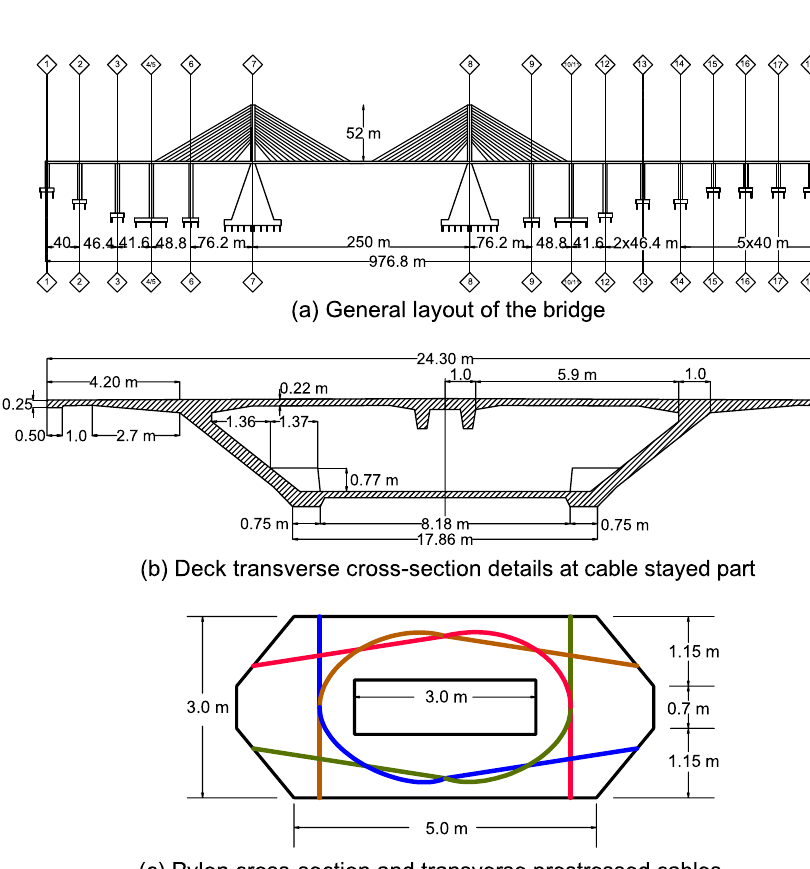
Fig. 2 General layout and typical cross sections of Aswan Cable‑Stayed Bridge. a General layout of the bridge. b Deck transverse cross‑section details at cable‑stayed part. c Pylon cross‑section and transverse